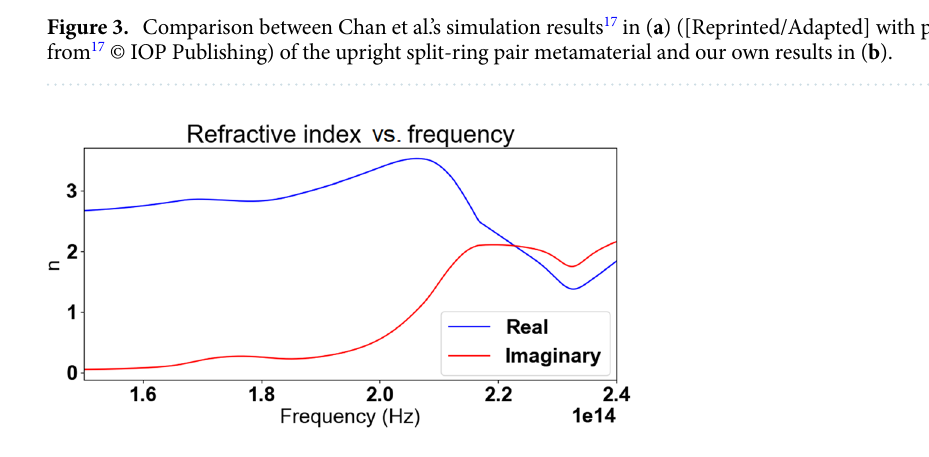
Figure 4. Numerically calculated refractive index of Chan et al.’s metamaterial after correction of the